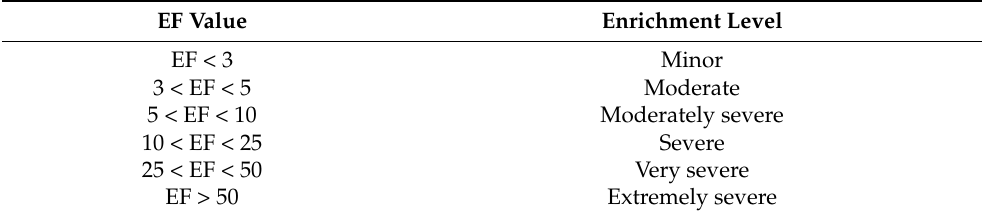
Table 2. Enrichment factor (EF)